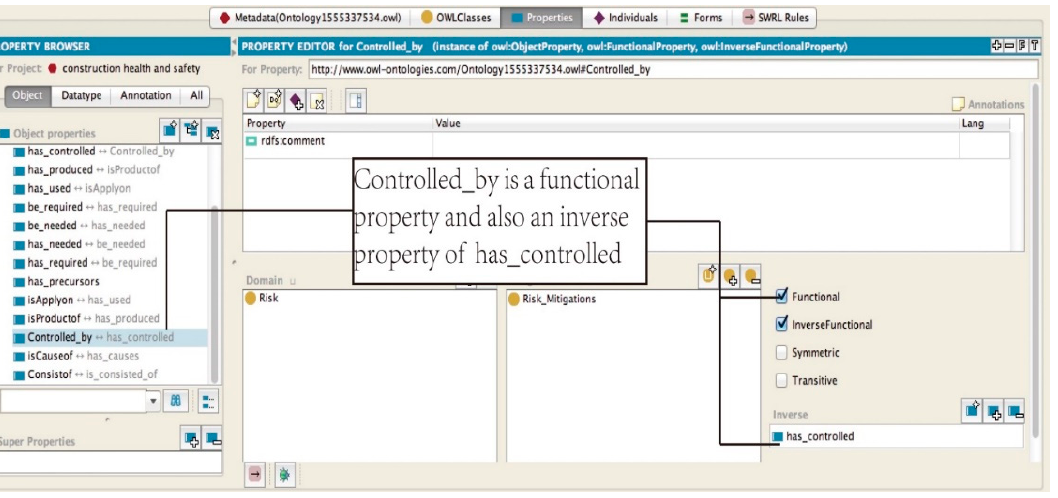
Figure 6. Inverse Property.